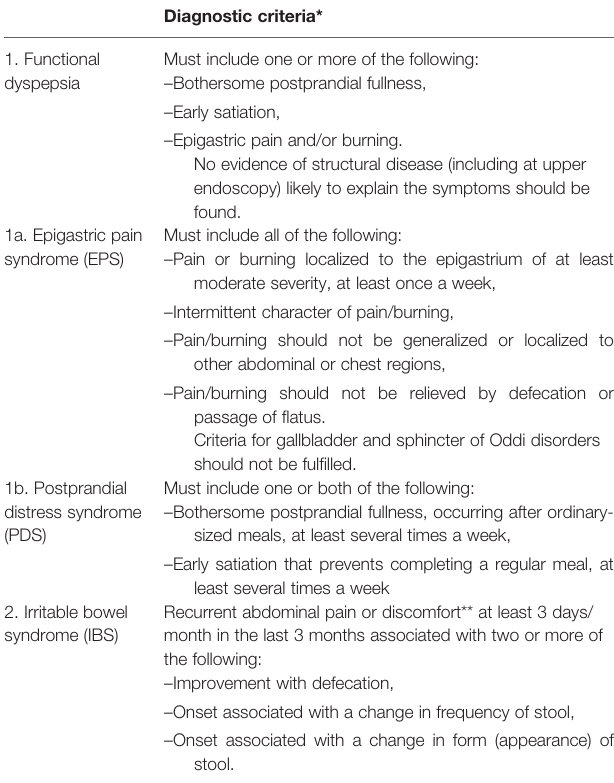
TABLE 1 | Summary of Rome III Criteria on